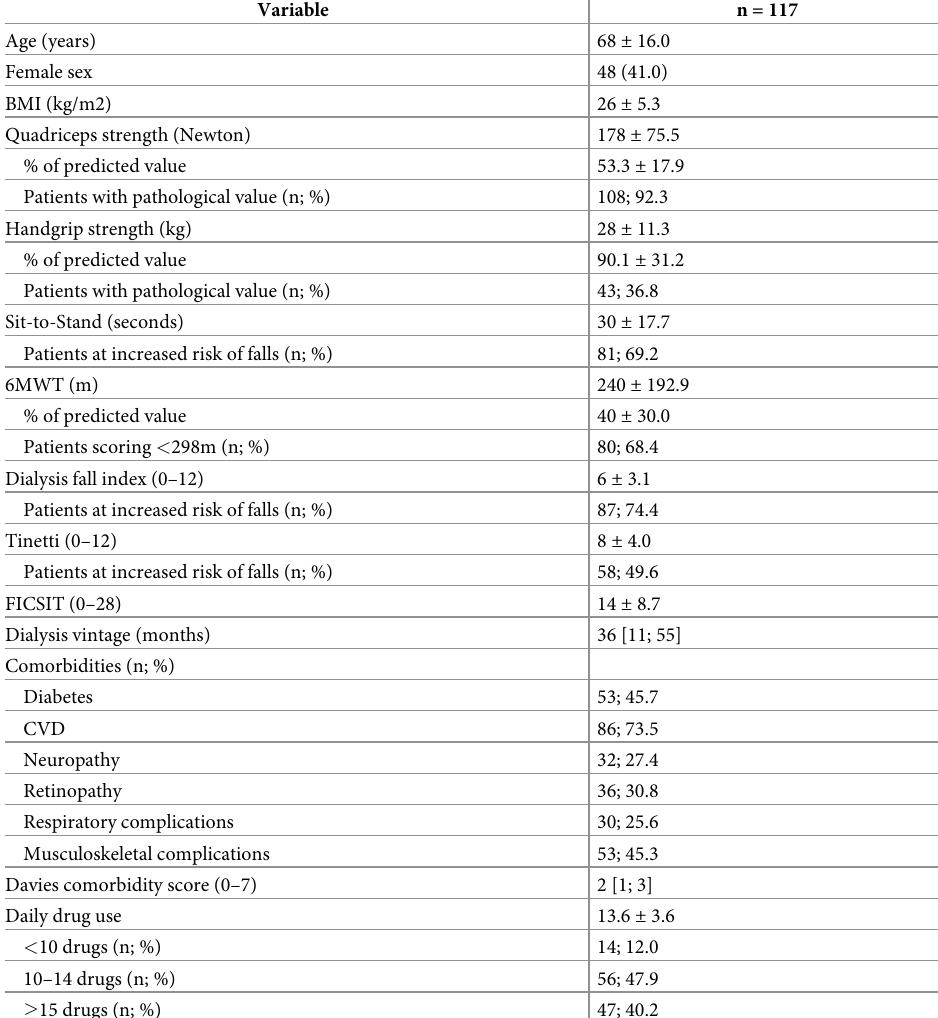
Table 1. Patient